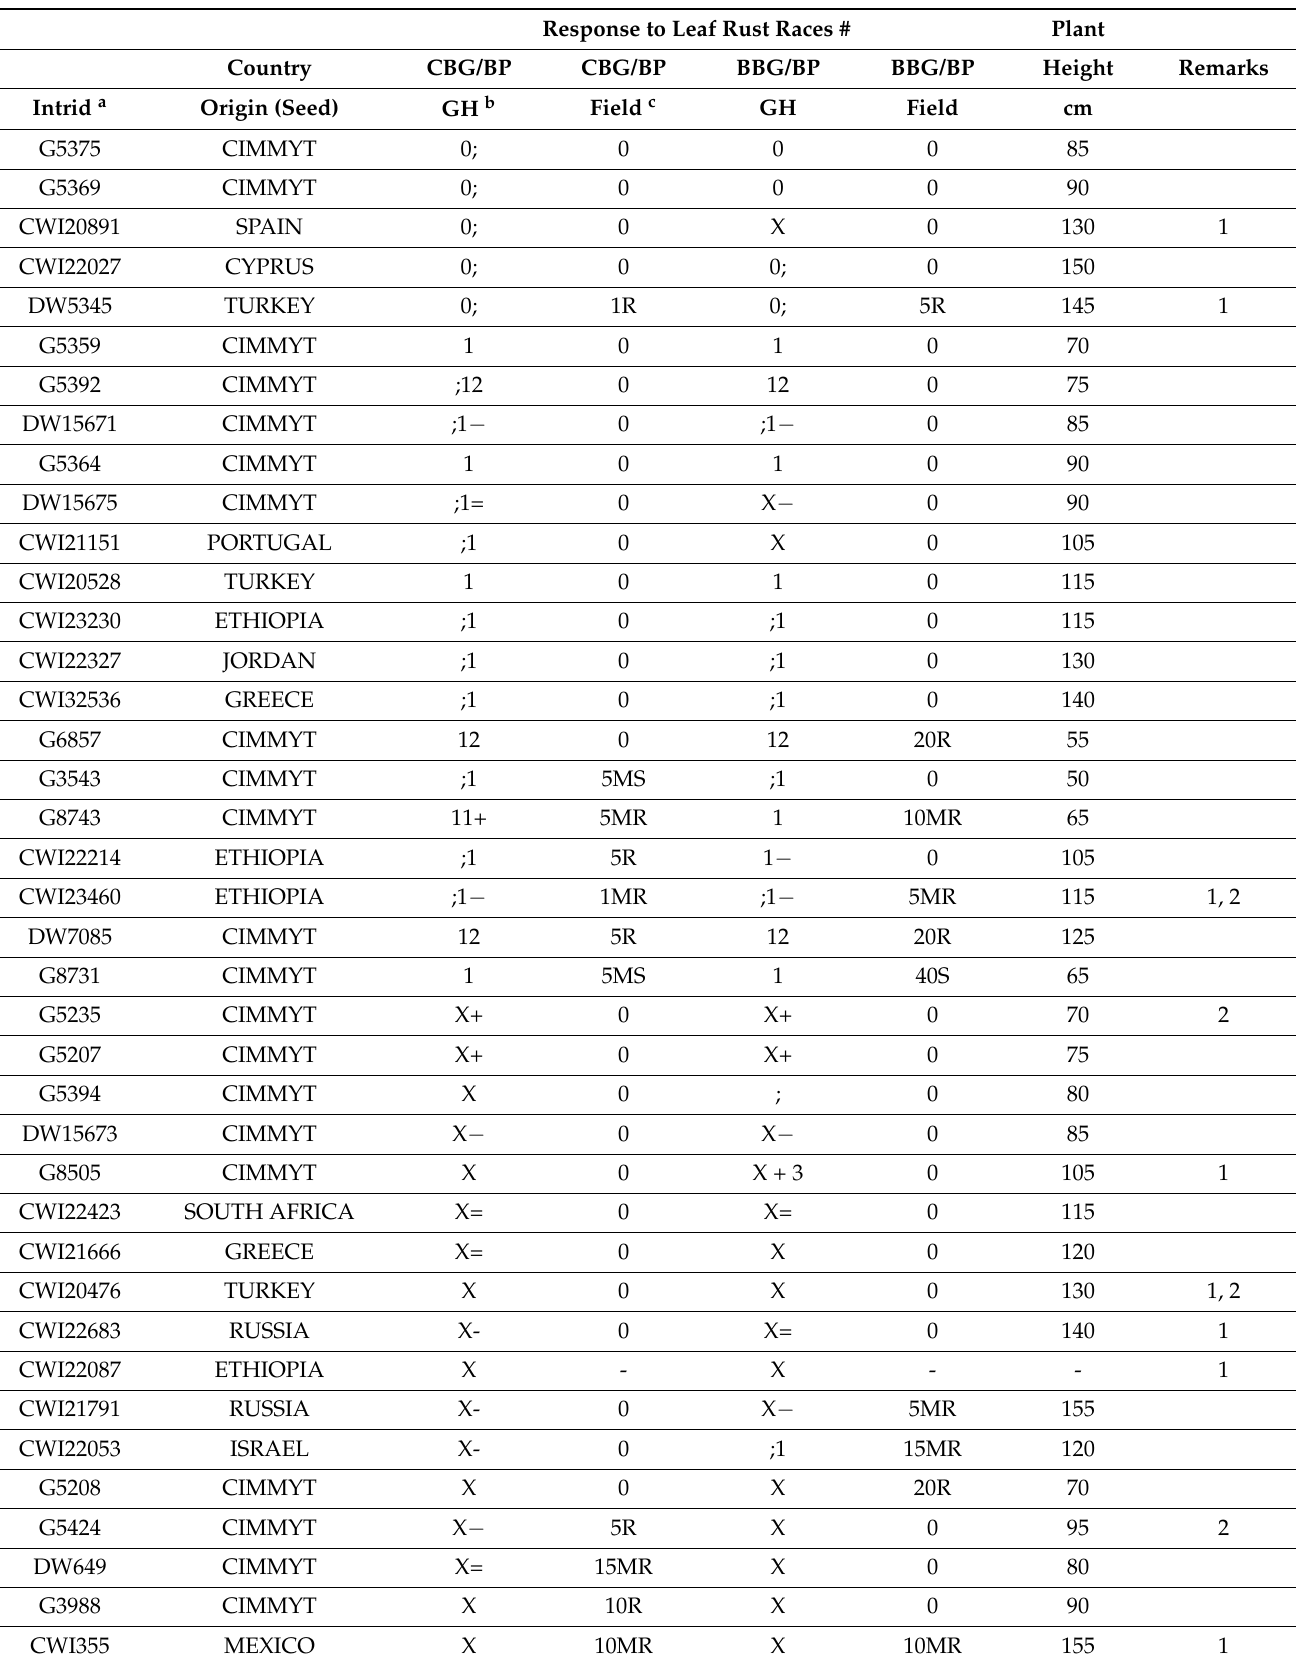
Table 1. Infection types at seedling (GH = greenhouse), final disease severity in the field in response to two leaf rust races, and plant height of selected seedling